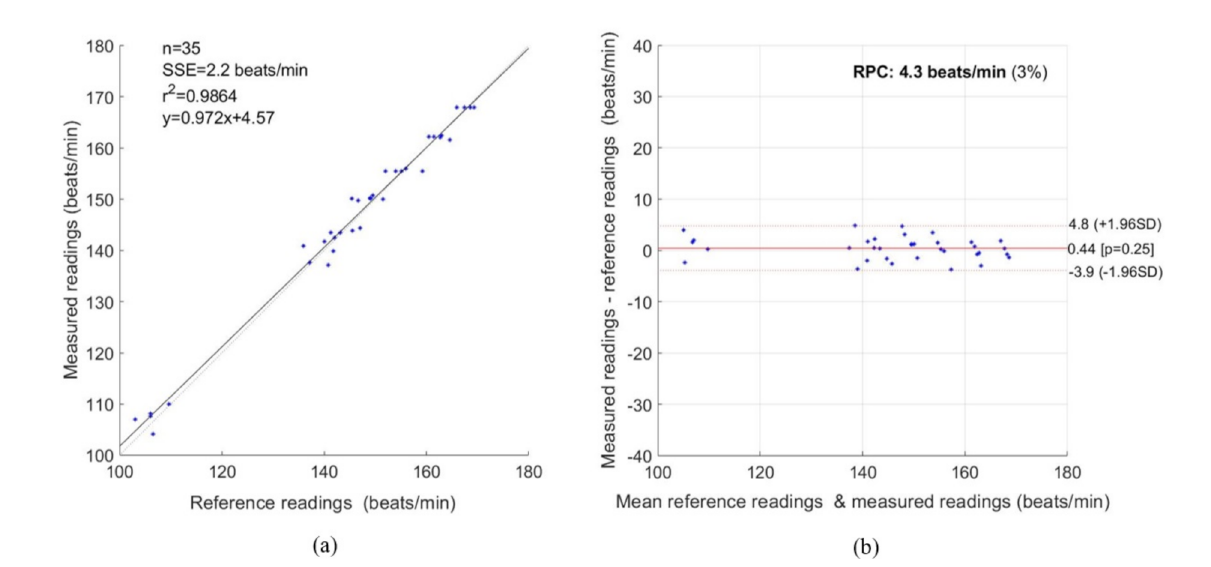
Figure 11. Statistical measurement for HR. ( a ) Correlation Plot, ( b ) Bland–Altman plot.